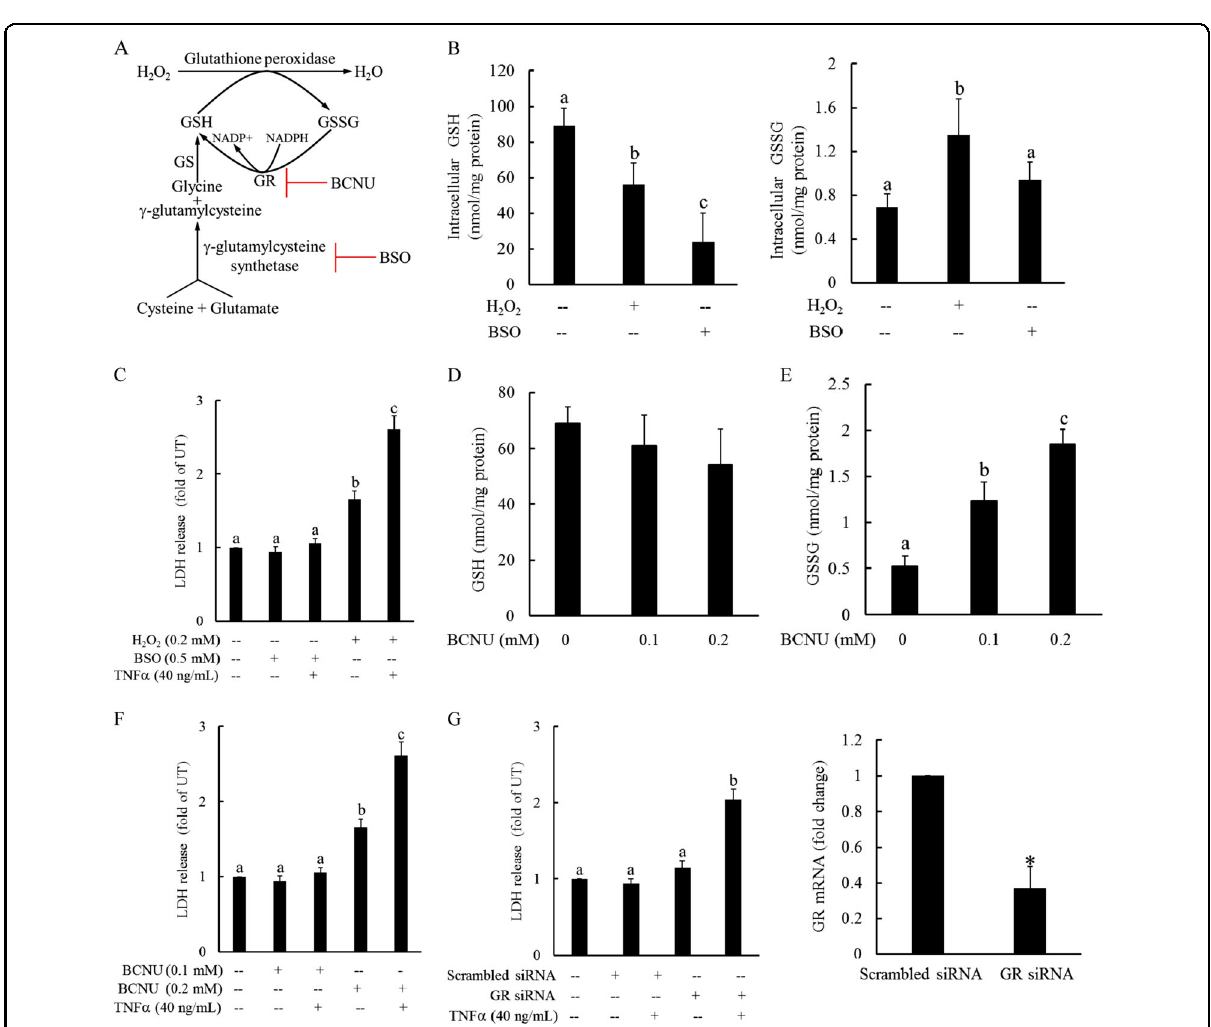
Fig. 3 Cellular GSSG accumulation renders hepatocytes susceptible to TNF α hepatotoxicity. a Schematic illustration of the glutathione synthesis pathway. HepG2 cells were pretreated with BSO (0.5 mM), a potent inhibitor of gamma-glutamylcysteine synthetase, for 2 h before H 2 O 2 (0.2mM) addition. b Intracellular GSH and GSSG levels. All values are expressed as the mean ± SD from three or more independent studies. Bars with different characters differ signi fi cantly ( p < 0.05). c BSO pretreatment had no effect on TNF α -induced cell death. HepG2 cells were pretreated